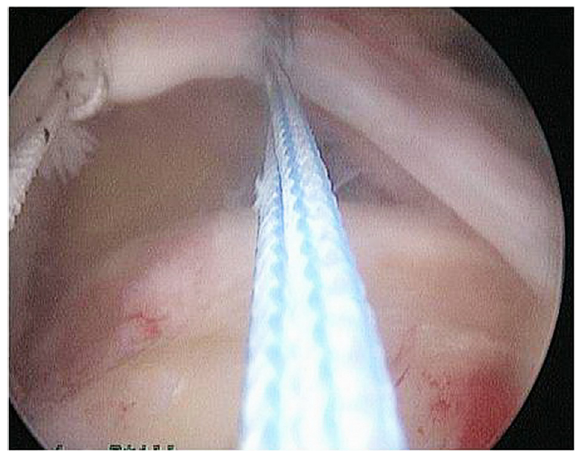
Figure 2. C-shaped, retracted, large size tear measuring 4 · 2.5 cm.